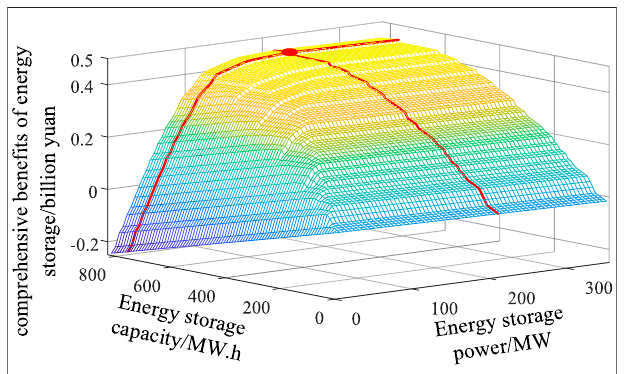
FIGURE7| Optimalprocessofcoordinatedplanningofsource-storage- transmission under dynamic time-of-use; electricity price based on the power trisection method.